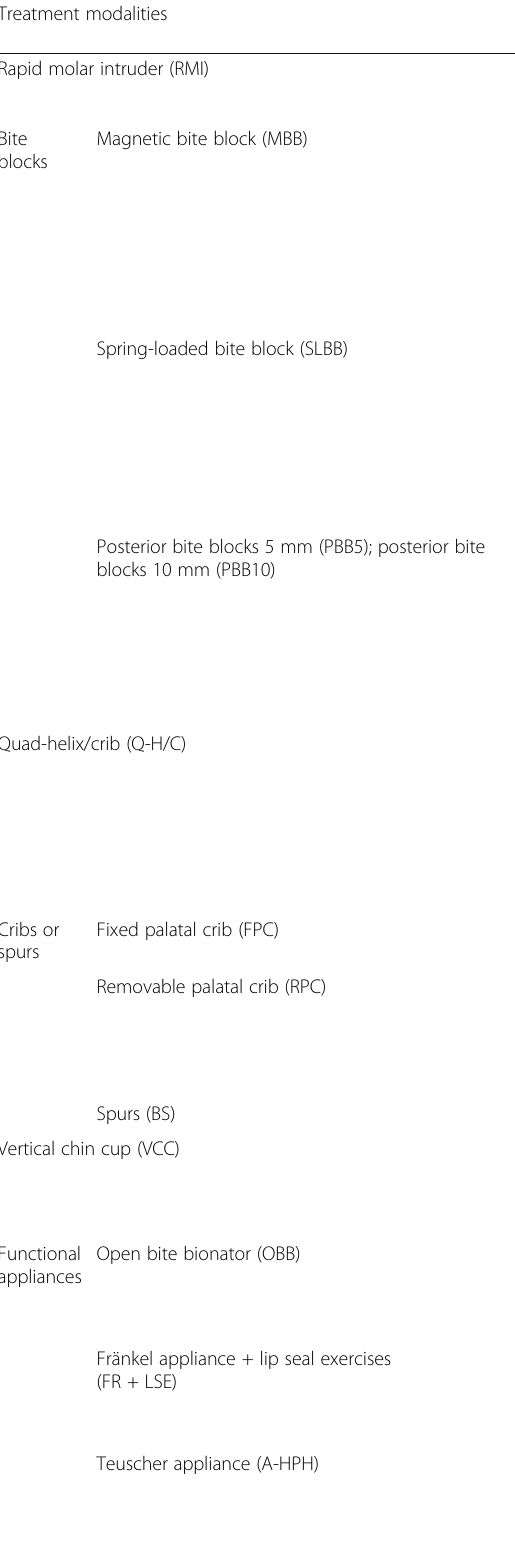
Table 4 Summary of